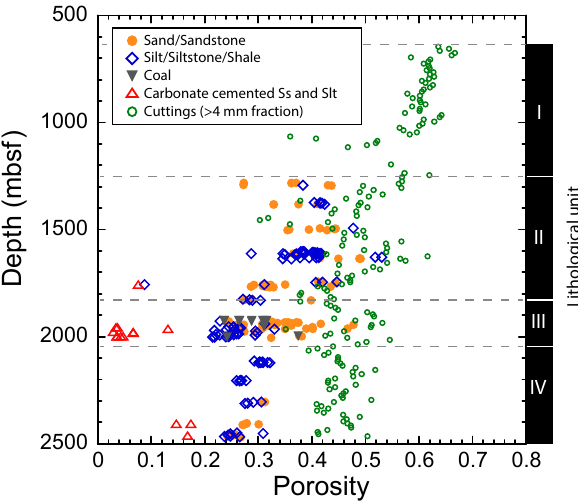
Figure 3. Distribution and lithological variation of porosity in dis- crete core samples with comparison of cuttings at Site C0020 (In- agaki et al., 2012; Tanikawa et al., 2016). Note that discrete core samples can be more representative for in situ porosity than poros- ity of